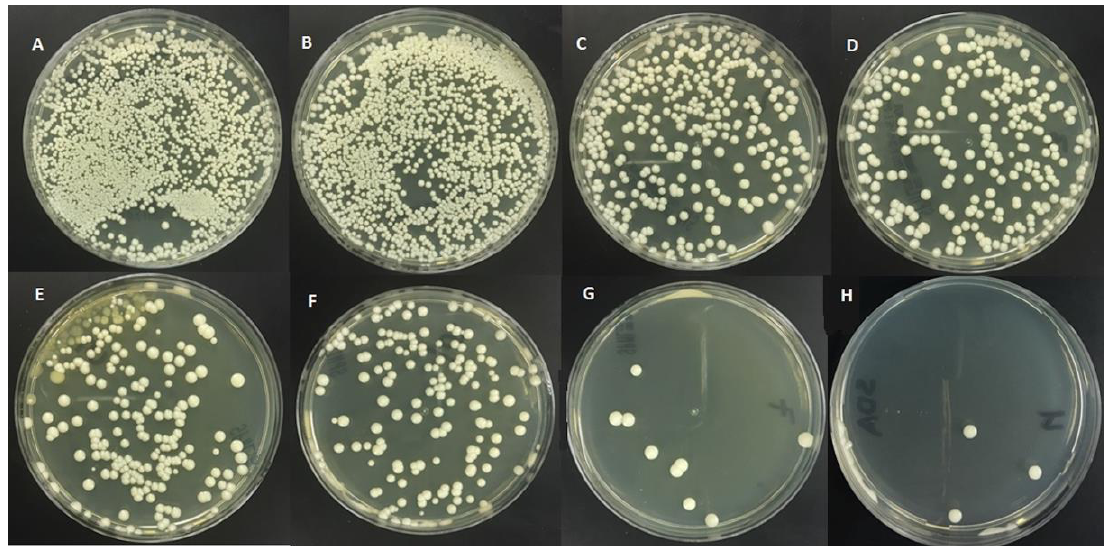
Figure 1. Cultures of Candida albicans colonies based on different concentrations of thymoquinone: ( A ) Control group (0%); ( B ) 0.5%; ( C ) 1%; ( D ) 1.5%; ( E ) 2%; ( F ) 2.5%; ( G ) 3%; ( H ) 5%.